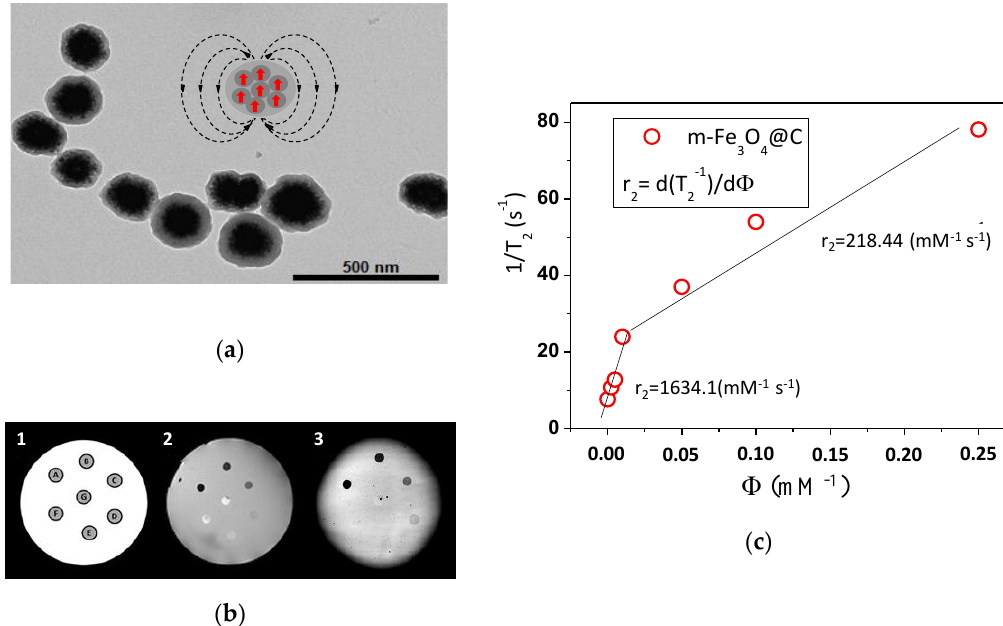
Figure 15. ( a ) TEM image of multi-Fe 3 O 4 @C NPs, ( b ) scheme of the phantom NPs concentration distribution (b.1): A = 0.25 mg / mL; B = 0.1 mg / mL; C = 0.05 mg / mL; D = 0.025 mg / mL; E = 0.005 mg / mL; F = 0.0025 mg / mL and G = 0 mg / mL; MR T2-weighted image of the agar phantom (b.2); MR T2*-weighted image of the agar phantom (b.2), performed at 9.4 T (BrukerBiospec) on a set of agar phantoms loaded with di ff erent concentrations of NPs (0.0025 to 0.25 mM) and ( c ) relaxivity calculated from T2 MRI relaxation on agar phantoms reprinted with permission from [25], IEEE, 2016.